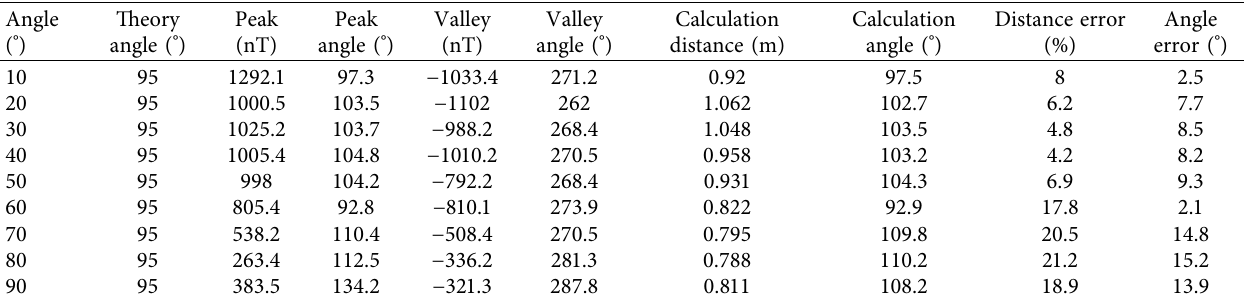
Figure 13: Calculation result of experiment point 3. (a) d � 0.5m. (b) d � 1 m. (c) d � 2 m. (d) d � 3m. (e) d � 4m. (f) d � 5 m. Table 3: Calculation result of different angles when the distance from sensor to casing is 1m.